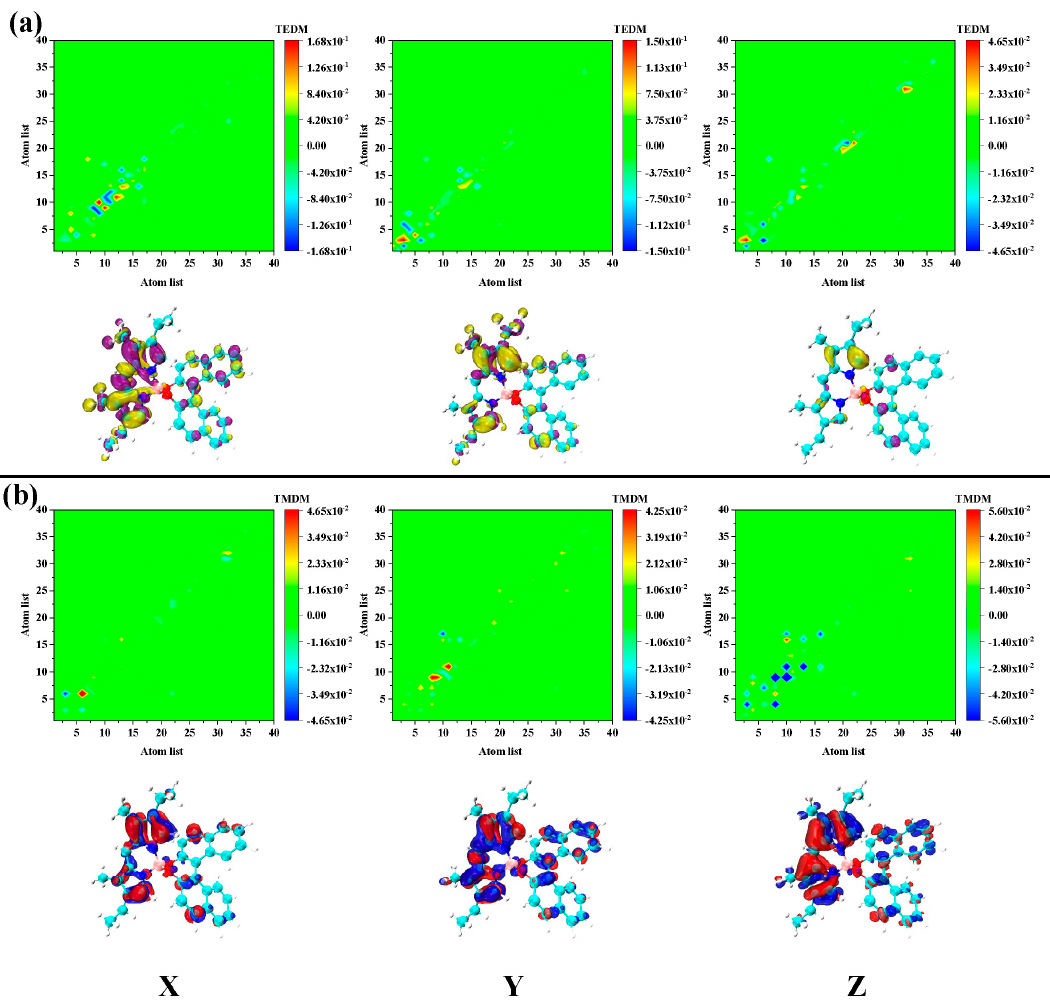
Figure 5. The transition ( a ) electric / magnetic ( b ) dipole moment matrix (upper) and density (under) isosurface of S 2 in PM567. The yellow and purple isosurfaces indicate the positive and negative transition electric dipole moments, respectively, and the red and blue isosurfaces represent the positive and negative transition magnetic dipole moment, respectively.